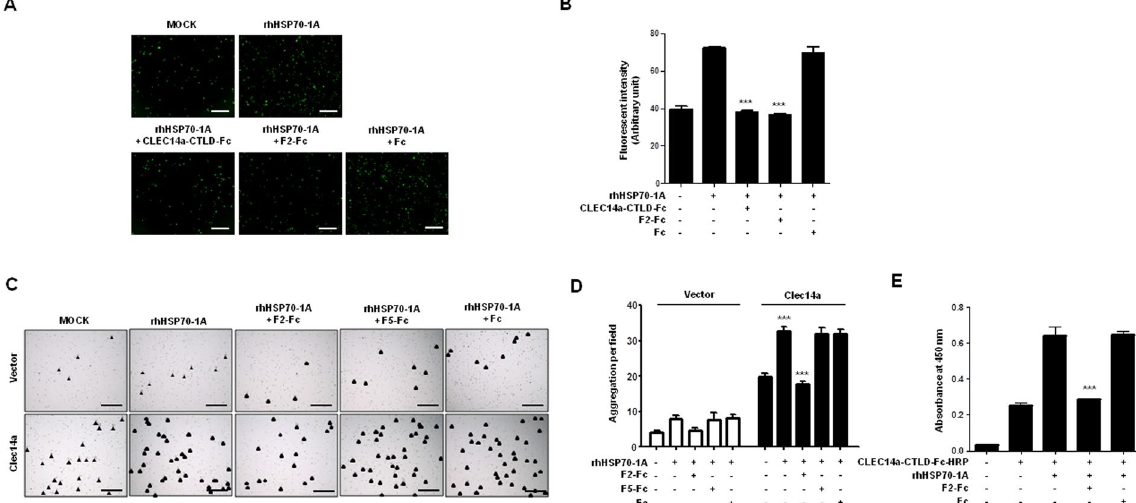
Figure 5. Effect of the HSP70-1A-interacting region of CLEC14a-CTLD on HSP70-1A-induced HUVEC cell adhesion and CLEC14-mediated cell-cell contact. ( A ) Representative images of the binding of calcein- AM-labeled HUVECs to HUVEC monolayers for 2 h in the absence (MOCK) or presence of 50 ng/ml rhHSP70-1A or 50 ng/ml rhHSP70-1A plus 20 μ g/ml CLEC14a-CTLD-Fc, F2-Fc, or Fc (scale bar = 400 µ m). ( B ) The fluorescence intensities obtained from the calcein-AM labeled HUVECs are expressed as a bar graph. ( C ) HEK293F cells transfected with CLEC14a were incubated in the absence (MOCK) or presence of 50 ng/ ml rhHSP70-1A or 50 ng/ml rhHSP70-1A plus F2-Fc, F5-Fc, or Fc for 8 h. Cell aggregates (mass > 4 cells; arrowheads) were counted under a light microscope (scale bar = 500 µ m). The number of aggregates per field is shown in. ( D ). ( E ) The binding of CLEC14a-CTLD-Fc-HRP to HUVECs incubated for 2 h in the absence or presence of 50 ng/ml rhHSP70-1A or 50 ng/ml rhHSP70-1A with 20 μ g/ml F2-Fc or Fc was measured by cell ELISA. All data are presented as the mean ± SEM of triplicate measurements from two independent experiments; *** P <